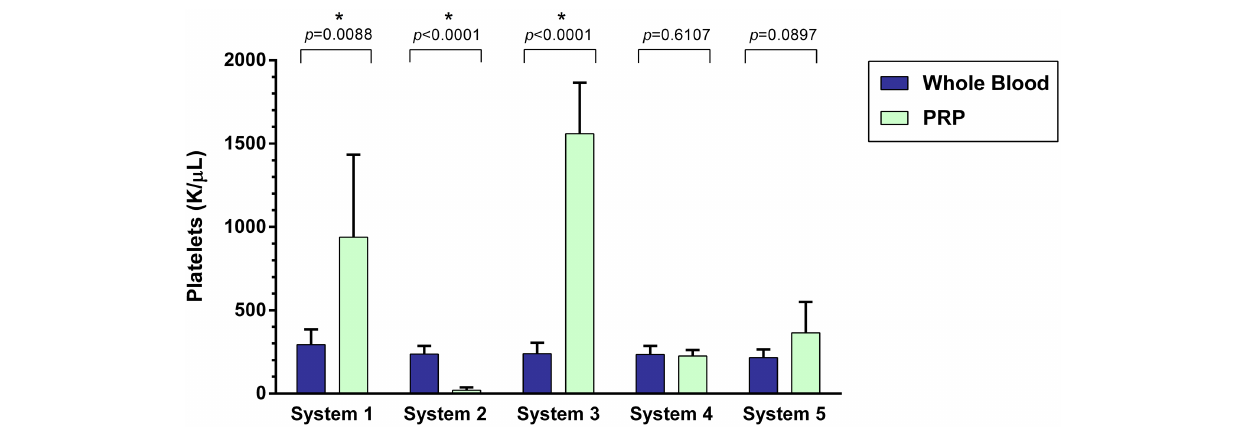
FIGURE 1 | Comparison of mean whole blood and mean PRP product platelet concentrations between five commercial PRP systems . An asterisk (*) indicates a statistically significant difference between the mean whole blood and mean PRP product for that PRP system. Bars represent mean (cid:6) 95% CI ( n =